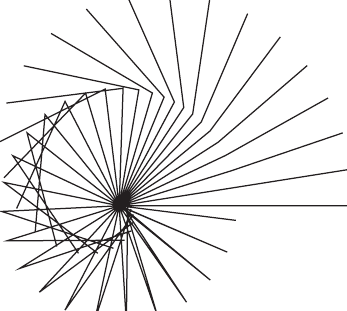
Figure 8: Sequence of configurations of the robot manipulator at times 𝑘/32 with 𝑘 = 0, 1,. .. ,32 corresponding to the optimal solution of problem 4, an initial value problem for an underactuated 𝑅𝑅 planar robot manipulator with boundary conditions 𝜃 1 (𝑡 𝐼 ) = 0[ rad ] , 𝜃 (𝑡 ) = 0[ rad ] , ̇ 𝜃 (𝑡 ) = 5[ rad / s ] , ̇ 𝜃 (𝑡 ) = 0[ rad / s ] , 𝜃 (𝑡 ) = free, 𝜃 (𝑡 ) = 𝜋 [ rad ] , ̇ 𝜃 (𝑡 ) = free, and ̇ 𝜃 (𝑡 ) = 0 [ rad / s ] , obtained 2 𝐼 1 𝐼 2 𝐼 1 𝐹 2 𝐹 1 𝐹 2 𝐹 with a discretization of [𝑡 𝐼 ,𝑡 𝐹 ] into 64 intervals. The initial and final times are 𝑡 𝐼 = 0 and 𝑡 𝐹 = 1 [ s ] , respectively. The corresponding control and state variables are represented in Figure